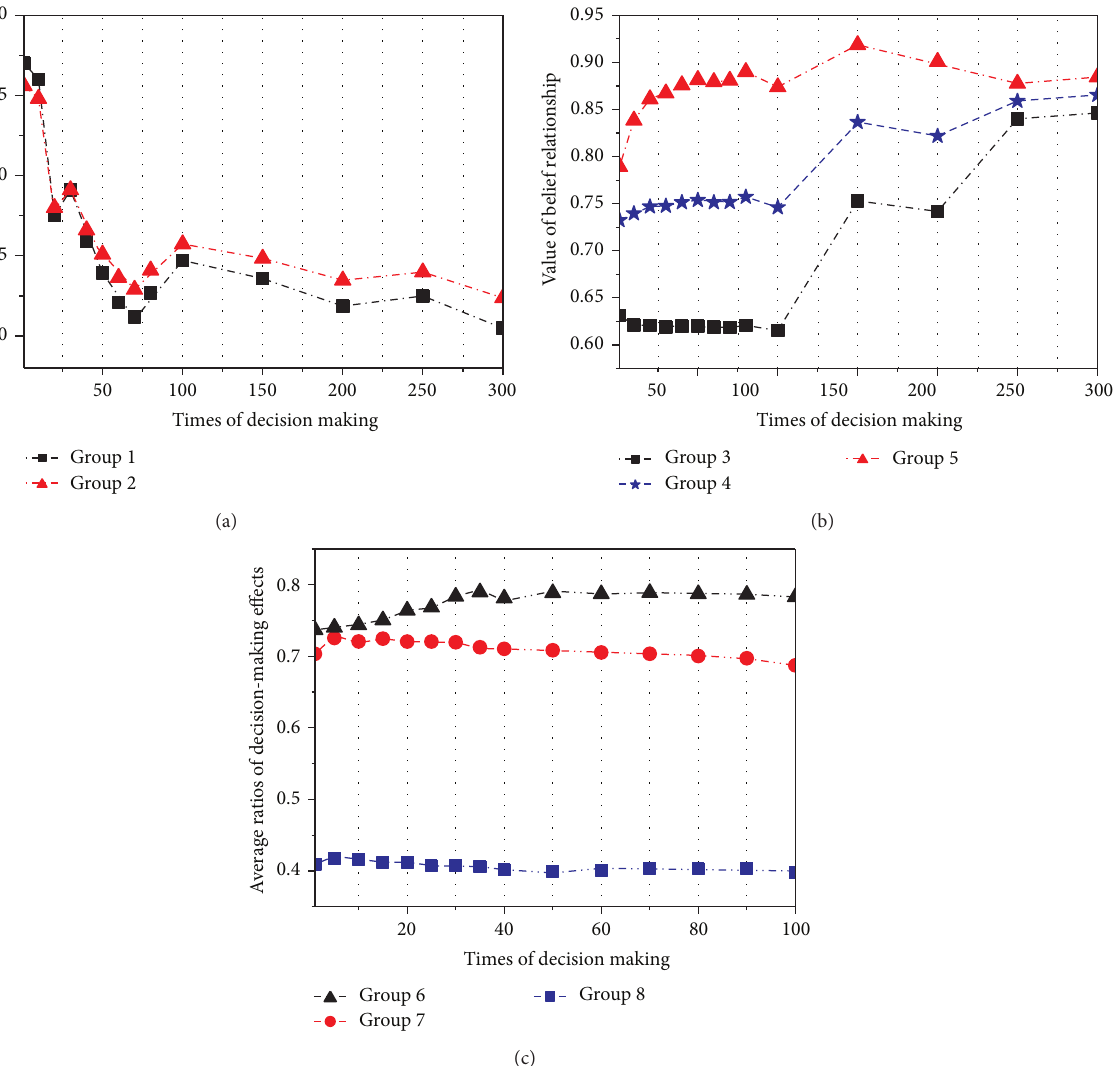
Figure 3: Effects of the belief computation